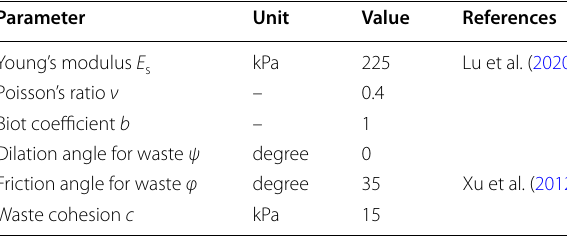
Table 4 Mechanical parameters used in this paper